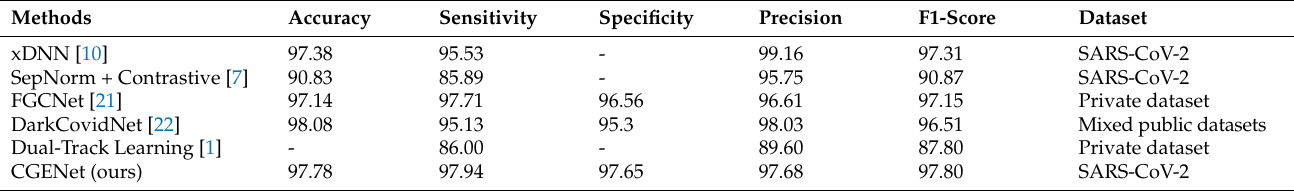
Table 8. Comparison with other existing approaches (unit: